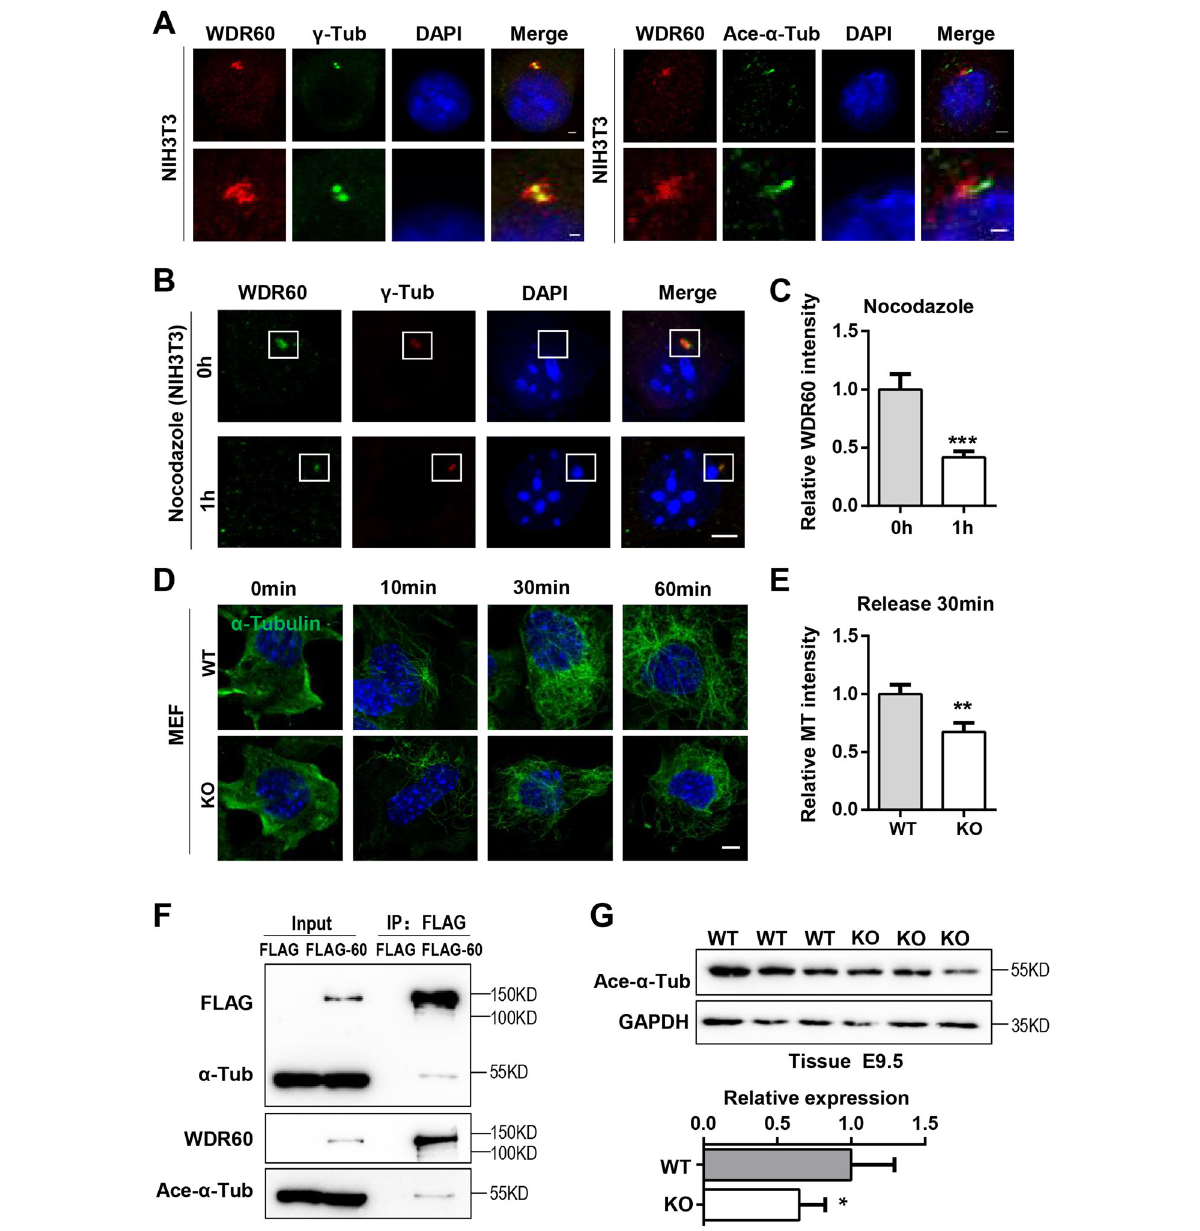
Fig. 3 Loss of WDR60 affects microtubule organization. a NIH3T3 cells were immunostained for WDR60 (red) and γ -Tubulin (green) or Ace- α - Tubulin (green). Scale bars: 2 μ m (upper), 1 μ m (lower). b , c Imagines of NIH3T3 cells were treated or untreated with nocodazole (2 μ g/ml) for 1 h and co-stained for WDR60 (green) and γ -Tubulin (red). Scale bars: 5 μ m. c Quanti fi cation of WDR60 intensity. 0 h n = 43, 1 h n = 48. d , e WT and Wdr60 KO MEF cells were treated with nocodazole for 1 h before release. Cells were fi xed at different time points and stained for α -Tubulin (green). Scale bar: 5 μ m. e Quanti fi cation of α -Tubulin intensity after released for 30 min. n = 54. f FLAG-Wdr60 was expressed in HEK293T cells and immunoprecipitated with FLAG beads and blotted for FLAG, α -Tub, Acetylated- α -Tub and WDR60. g Mouse tissues from WT and Wdr60 KO at E9.5 were immunoblotted for Ace- α -Tubulin and GAPDH. Lower panel: quanti fi cation of Ace- α -Tubulin expression. All data are means ± SEM, t -test. * p < 0.05, ** p < 0.01, *** p <